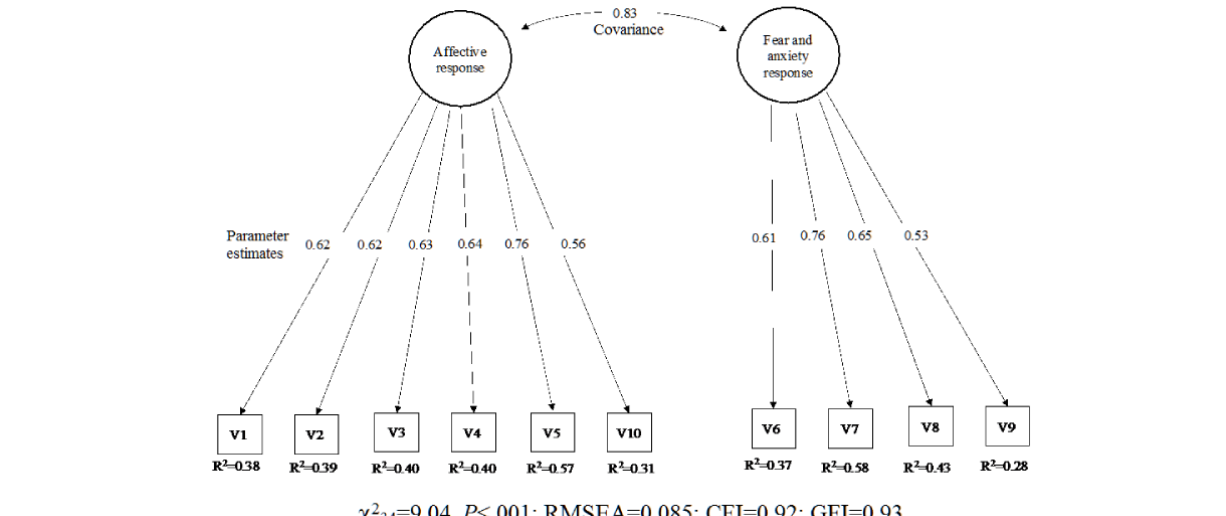
Figure 2. Path diagram of the confirmatory factor analysis. Standardized weights and measurement errors of each item of the Self-applied Acute Stress Scale (EASE). CFI: comparative fix index; GFI: goodness-of-fit index; RMSEA: root mean square error of approximation; V1: I can’t help but think of recent critical situations. I can't get out of work; V2: I have completely lost the taste for things that gave me peace of mind; V3: I keep my distance, I resent dealing with people, and I'm irascible even at home; V4: I feel that I am neglecting many people who need my help; V5: I have difficulty thinking and making decisions, I have many doubts, and I have entered a kind of emotional blockage; V6: I feel intense physiological reactions (shock, sweating, dizziness, shortness of breath, insomnia, etc) related to the current crisis; V7: I feel on permanent alert. I believe that my reactions now put other patients, my colleagues, or myself at risk; V8: Worrying about not getting sick causes me a strain that is hard to bear; V9: I'm afraid I'm going to infect my family; V10: I have difficulty empathizing with patients' suffering or connecting with their situation (emotional distancing and emotional